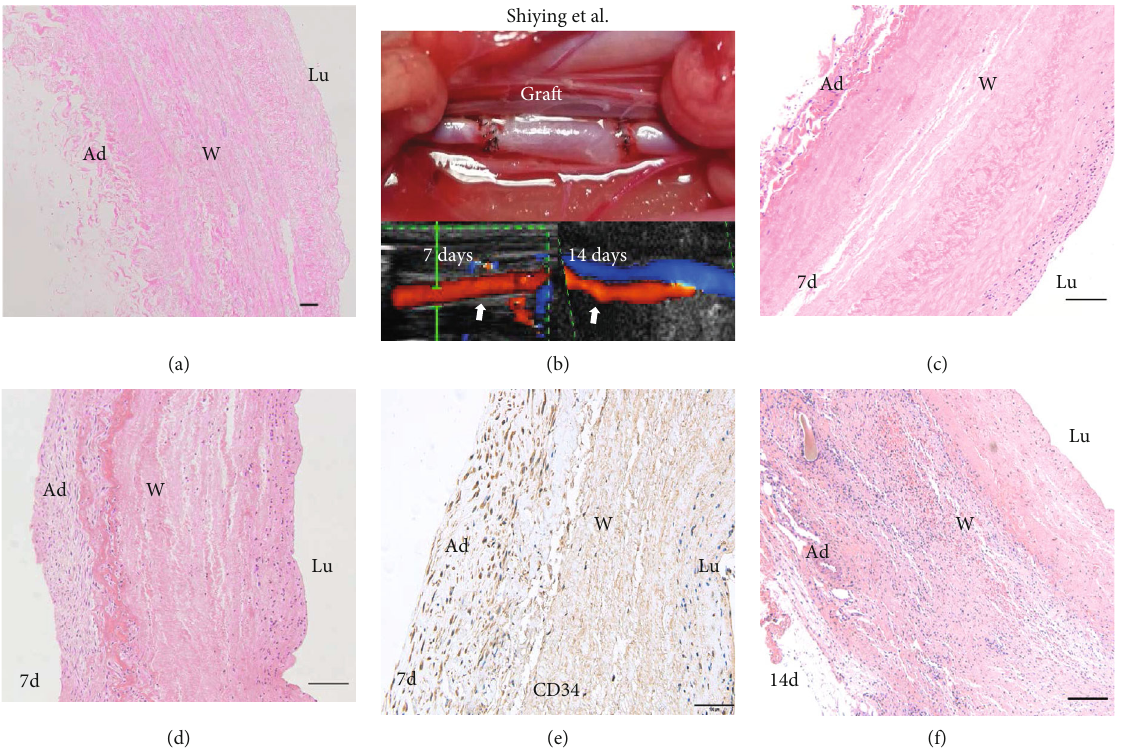
Figure 3: The cells outside-in migration into decellularized HGSV. (a) No cell nuclei was visible with HE staining of decellularized vessels. (b) The infrarenal abdominal aorta of rabbit was replaced by decellularized HGSV. The white arrow indicates the patented transplants by ultrasonic examination at 7-day and 14-day replacement. (c) At 7-day replacement, there were a small number of cells in the adventitia of sca ff old far from anastomoses; meanwhile, there were several cells emerged from the intima and seldom in tunica media. (d) At 7-day replacement, there were a large number of cells in the adventitia of sca ff old close to anastomoses; meanwhile, a large number of cells have emerged in the intima and a few in the tunica media. (e) A large amount of CD34 + cells in the adventitia of sca ff old and a small number of CD34 + cells in the intima. (f) Cells entered into the three layers of the sca ff old at 14-day replacement. Ad: adventitia of sca ff old; W: wall of sca ff old; Lu: lumen of sca ff old. Scale bars: 25 μ m (a); 50 μ m (c, d, and f); 100 μ m (e). Magni fi cation: 100x (b, c, d, and f); 200x